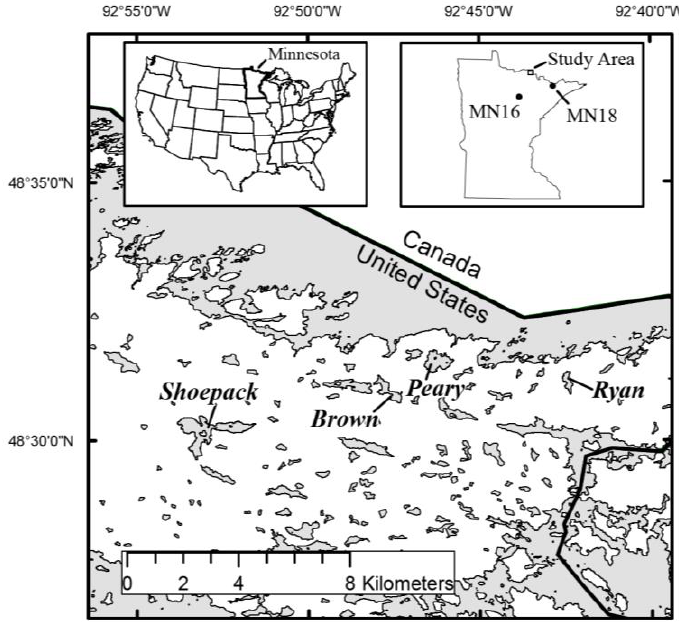
Figure 1. Location of four study lakes within Voyageurs National Park, and nearby National Atmo- spheric Deposition Program precipitation-monitoring sites MN16 and MN18. Table 2. Selected lake characteristics [22,26]; and selected water-column measurements from the approximate centroid of each lake [24]. [W.A., watershed area; % Wetlands, wetlands as a percentage of watershed area; Renewal time = mean hydraulic residence time, in years; ANC, acid-neutralizing capacity; µeq L −1 , microequivalents per liter; TOC, total organic carbon; mg L −1 , milligrams per liter].